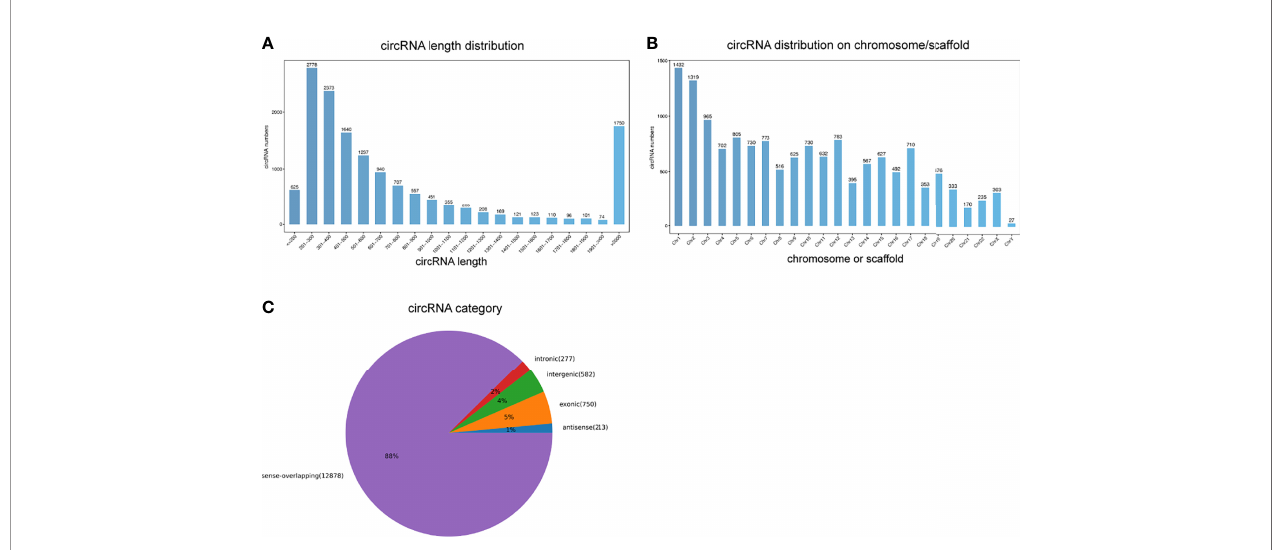
FIGURE 1 | Overview of circRNAs pro fi les. (A) The length distribution of circRNAs. (B) The chromosome distribution of circRNAs. (C) The gene structure distribution of circRNAs.